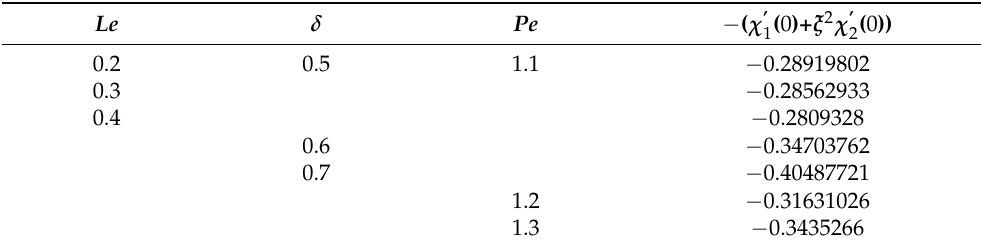
Table 4. Numerical estimation of the number density of microorganisms ( N n R ex − 1 2 ) for different parameters Le , δ , Pe .